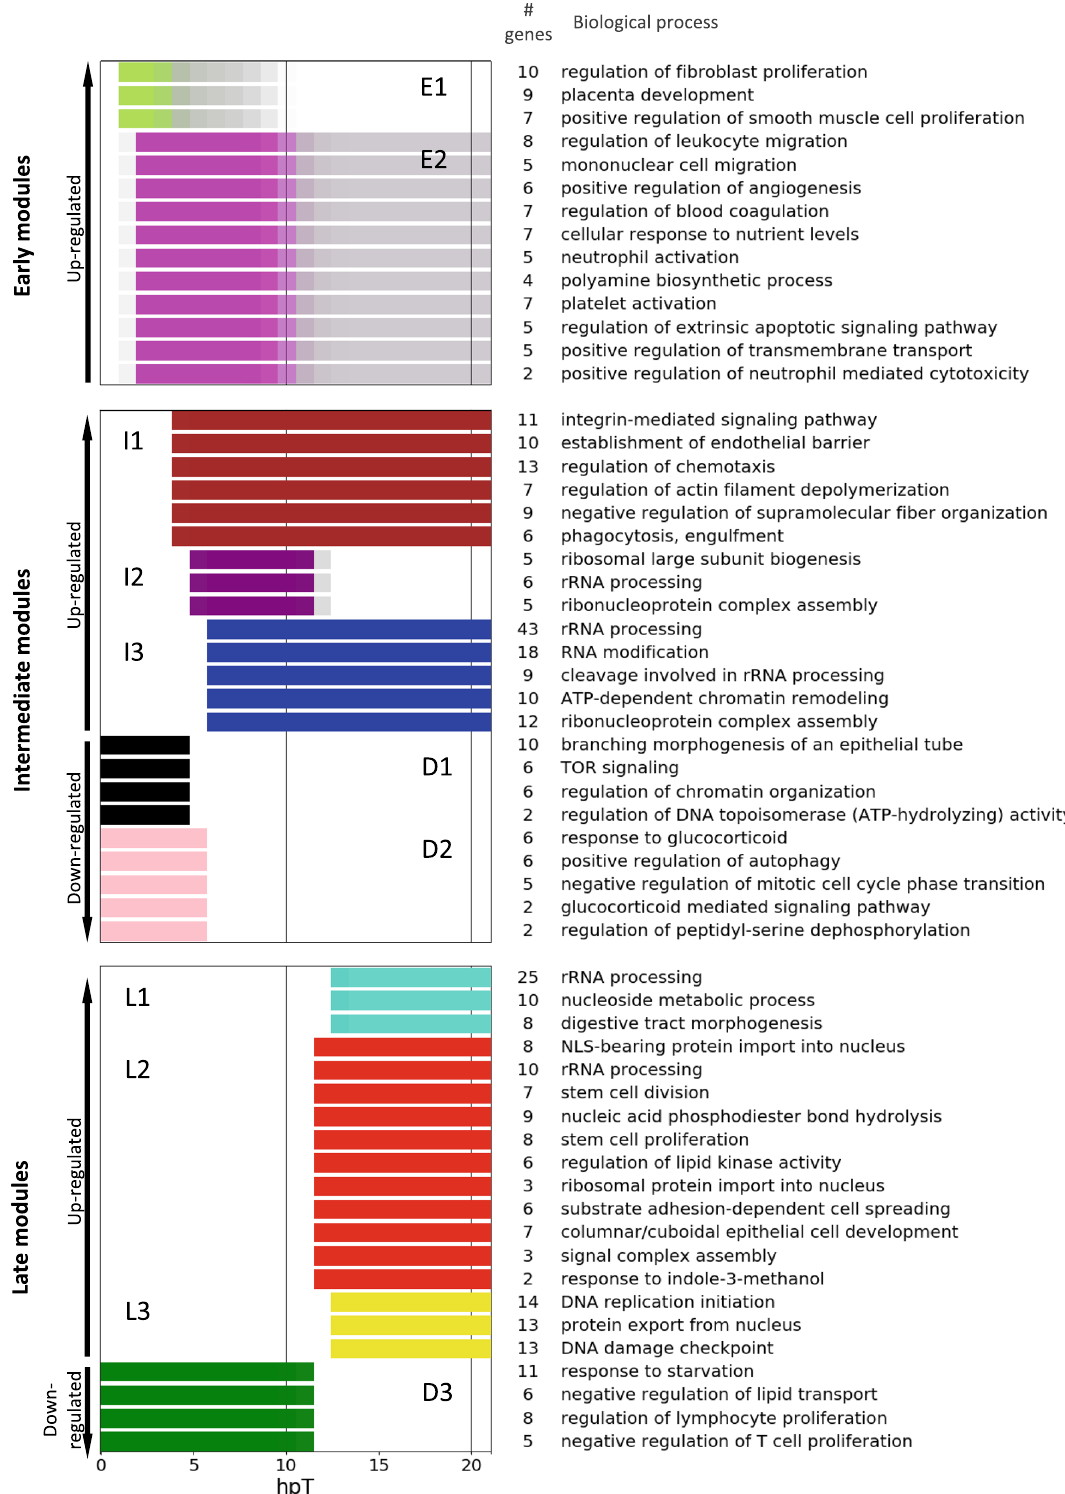
Fig. 3 Biological process regulated during the early response to spinal cord injury. Gene ontology enrichment analysis was performed for each co-expression module. The most representative biological processes are described. Color bars associated with each GO term represent the time period when they showed maximum expression. For downregulated modules, the color bars disappear when the expression levels of those genes start to decrease. The number of genes in each GO group is also